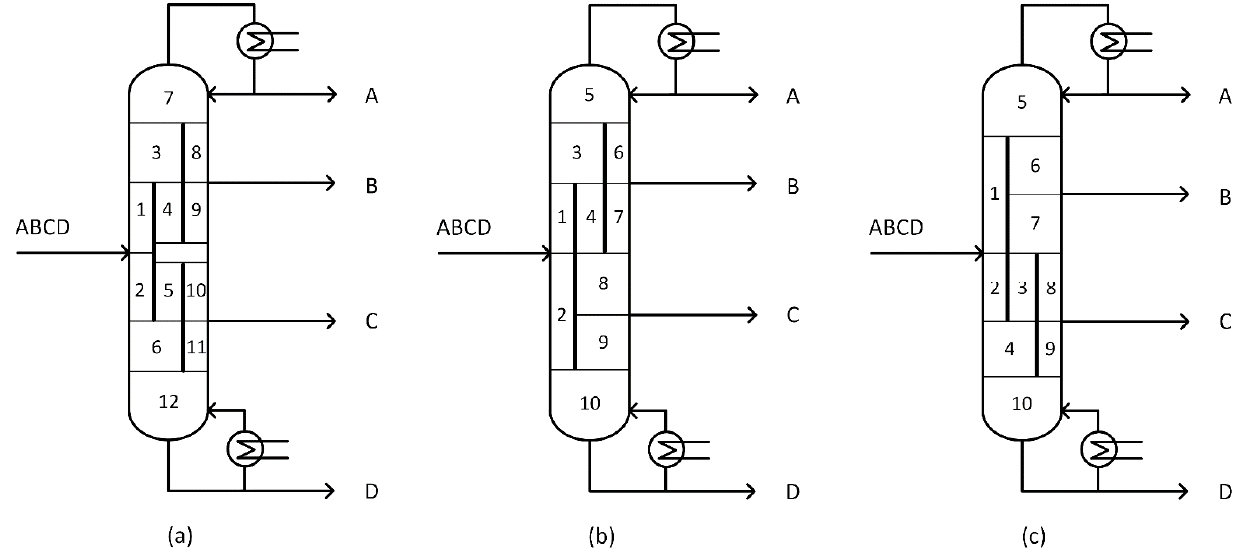
Figure 2. Different kinds of mDWC: ( a ) 2-3-4 configuration, ( b ) 2-2-4-a configuration, and ( c ) 2-2-4-b configuration. The separation sections are indicated by the numbers inside the columns.